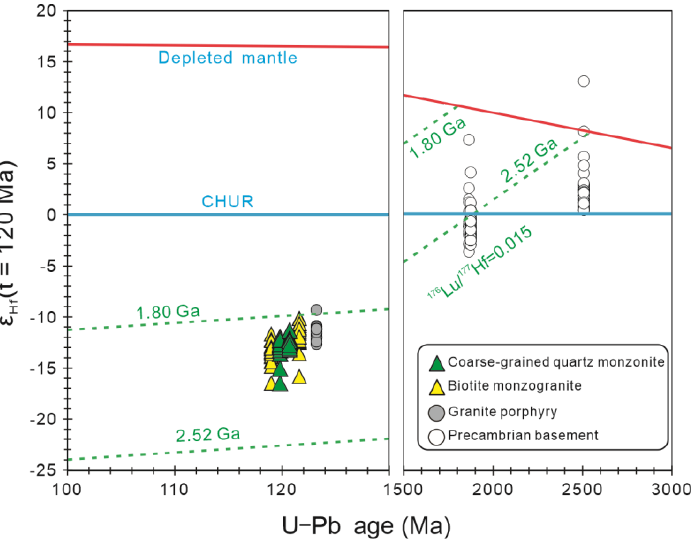
Figure 10. Plot of zircon ε Hf (t) value versus U-Pb age for the coarse-grained quartz monzonite, biotite monzogranite, and granite porphyry in the Yushulinzi pluton. All of the ε Hf (t) values were calculated from the zircon U-Pb ages. The data for the Precambrian basement are quoted from the literature [84 – 87].